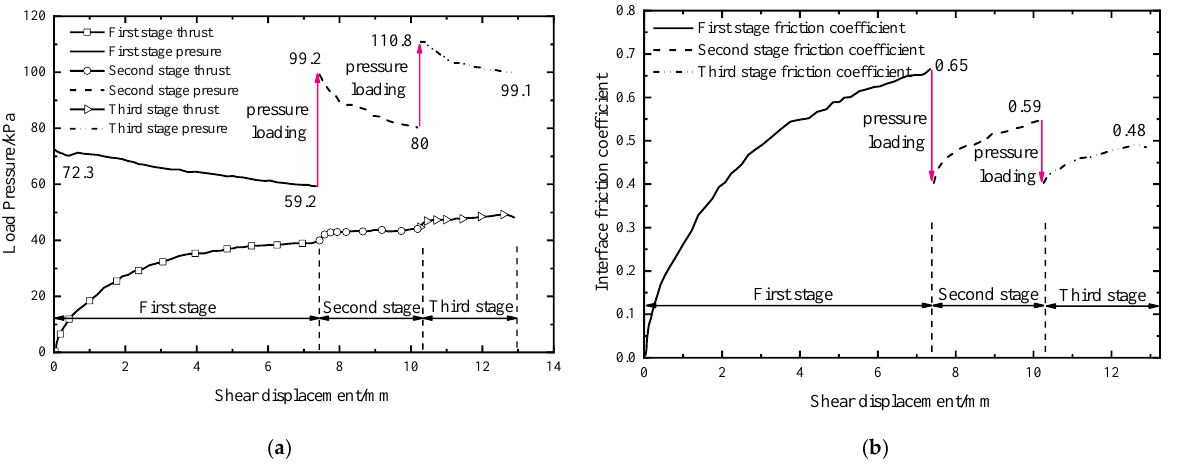
Figure 15. Interface shear test results of the T CL-S group: ( a ) T CL-S group load displacement curve and ( b ) T CL-S group friction coefficient displacement curve.